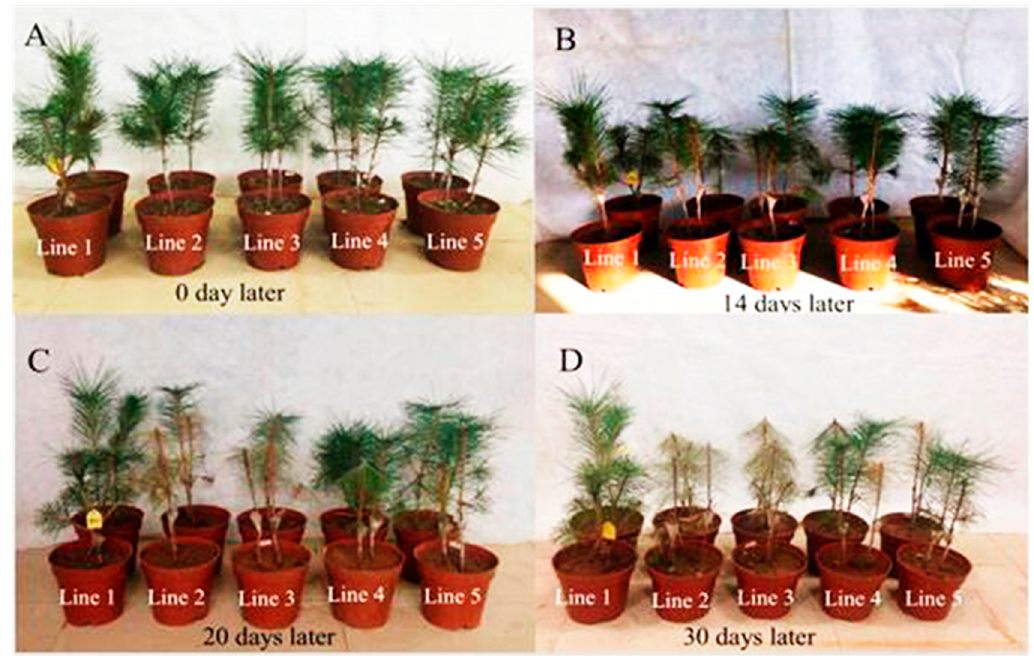
Figure 7. Symptoms in P. thunbergii seedlings: 0 day ( A ); 14 days ( B ); 20 days ( C ); and 30 days ( D ) after inoculation with nematodes soaked in ddH 2 O (line 2), ds GFP (line 3), d sBxATG1 (line 4), and ds BxATG8 (line 5) solutions. P. thunbergii seedlings treated with ddH 2 O alone were considered as controls (line 1). Each pot contains two P. thunbergii seedlings.